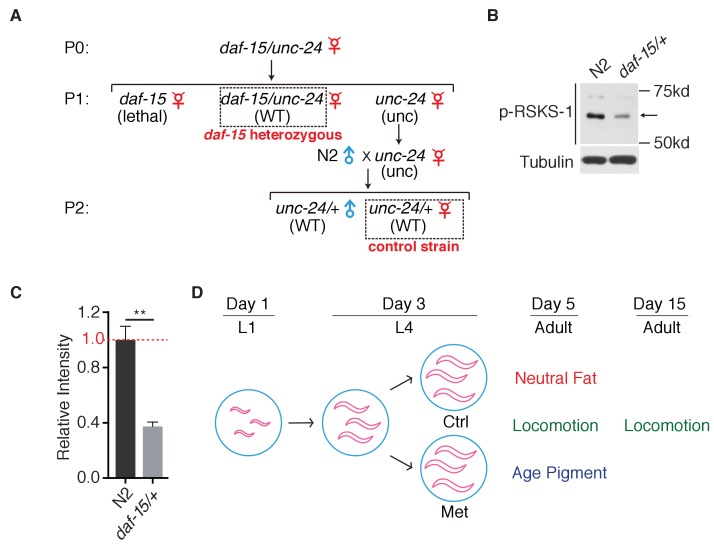
Deletion of daf-15 suppresses TORC1 activity.(A) Generation of daf-15 heterozygous mutants and its corresponding control animals. (B) Representative immunoblottings of RSKS-1 phosphorylation in N2 or daf-15 heterozygous mutants. (C) Quantification of immunoblots in (B). Relative intensities of 3 independent biological replicates are shown as mean ± SEM. (D) Schematic representation of experimental design for the detection of healthspan parameters. ns, no significant difference; *p<0.05; **p<0.01; ***p<0.001.